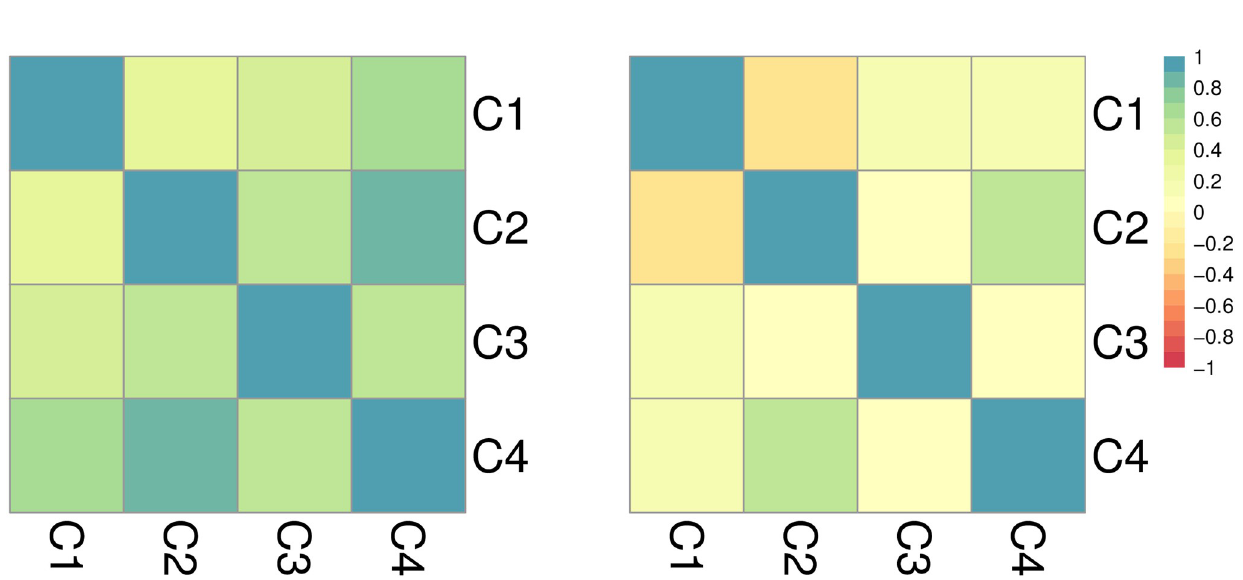
Fig 12. Cluster dynamics in Mexico: (left) Pearson’s correlation of weekly events n j across pairs of clusters. (right) Pearson’s correlation of = n . The left panel shows a high level of correlation between clusters; however, contrary to what observed in India differentiated weekly events Δ n j j − n j − 1 and Israel, dramatic decreases are observed when computing coefficients between first order differences implying a low level of synchrony in the rate of change of